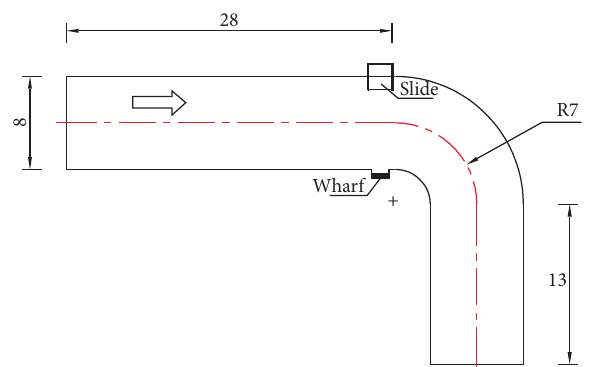
Figure 1: Plane layout of the wave basin; geometrical measure- ments were in